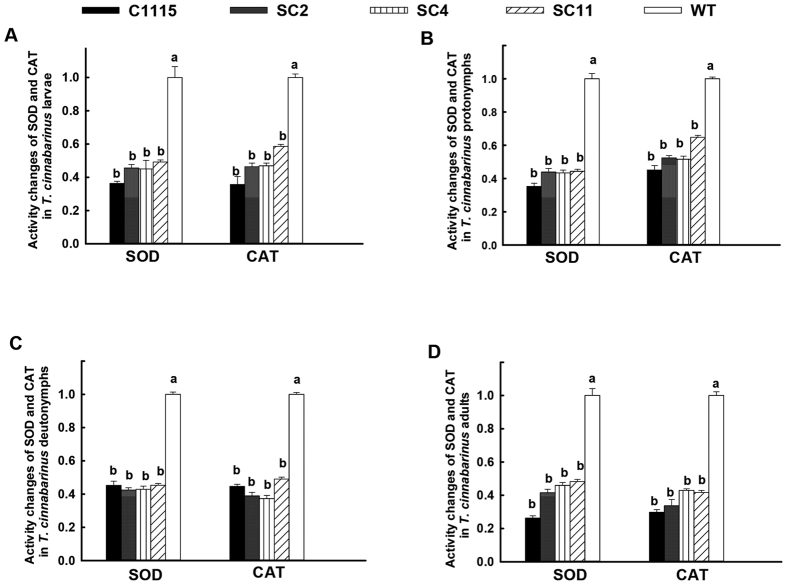
Changes in SOD and CAT activities in T. cinnabarinus feeding on transgenic cassava lines.(A) larvae, (B) protonymphs, (C) deutonymphs, and (D) adults. The activities of SOD or CAT in the WT were set as 1.0, and the changes in SOD or CAT activities were presented as the ratio of the activities in different developmental stages of T. cinnabarinus feeding on transgenic cassava lines and C1115 relative to those in T. cinnabarinus feeding on WT. Different letters above the standard error bars indicate significant differences based on the one-way ANOVA followed by Tukey’s HSD multiple comparison test (P < 0.05).